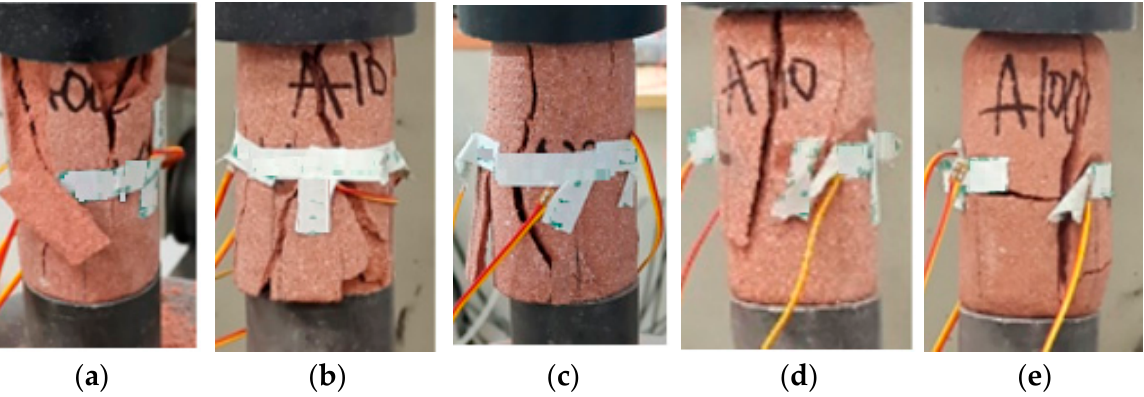
Figure 11. Failure modes of samples. ( a ) 0 cycle; ( b ) 10 cycles; ( c ) 30 cycles; ( d ) 70 cycles; and ( e ) 100 cycles